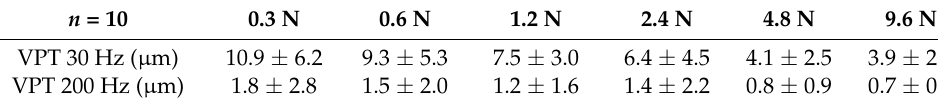
Table 1. Vibration perception thresholds [µm] for each contact force (N) and frequency (Hz). n =